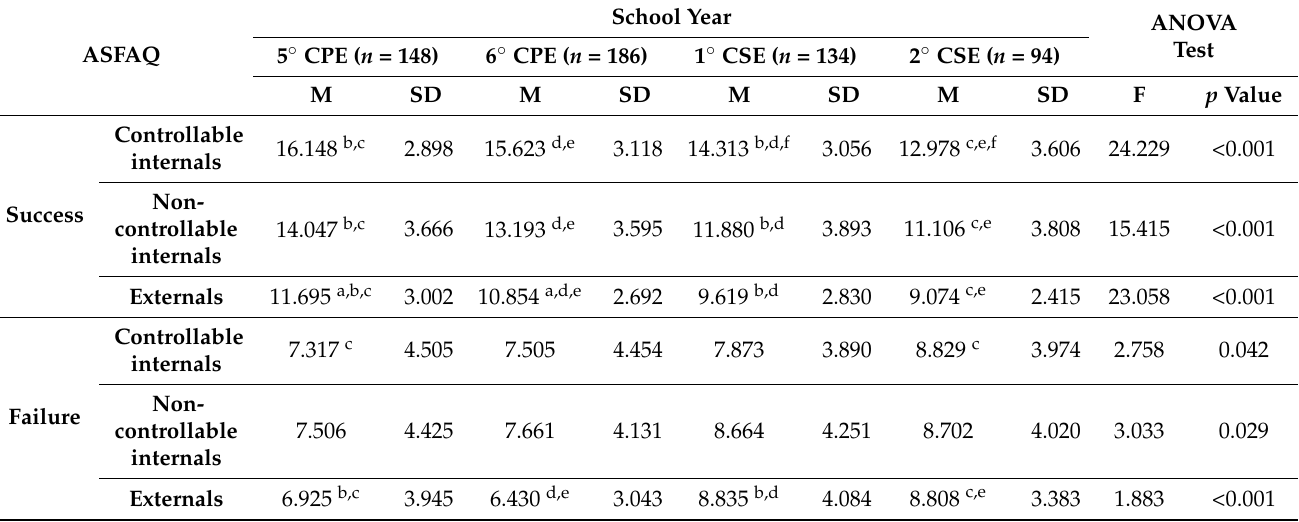
Table 6. Results of the ANOVA test between ASFAQ and the school